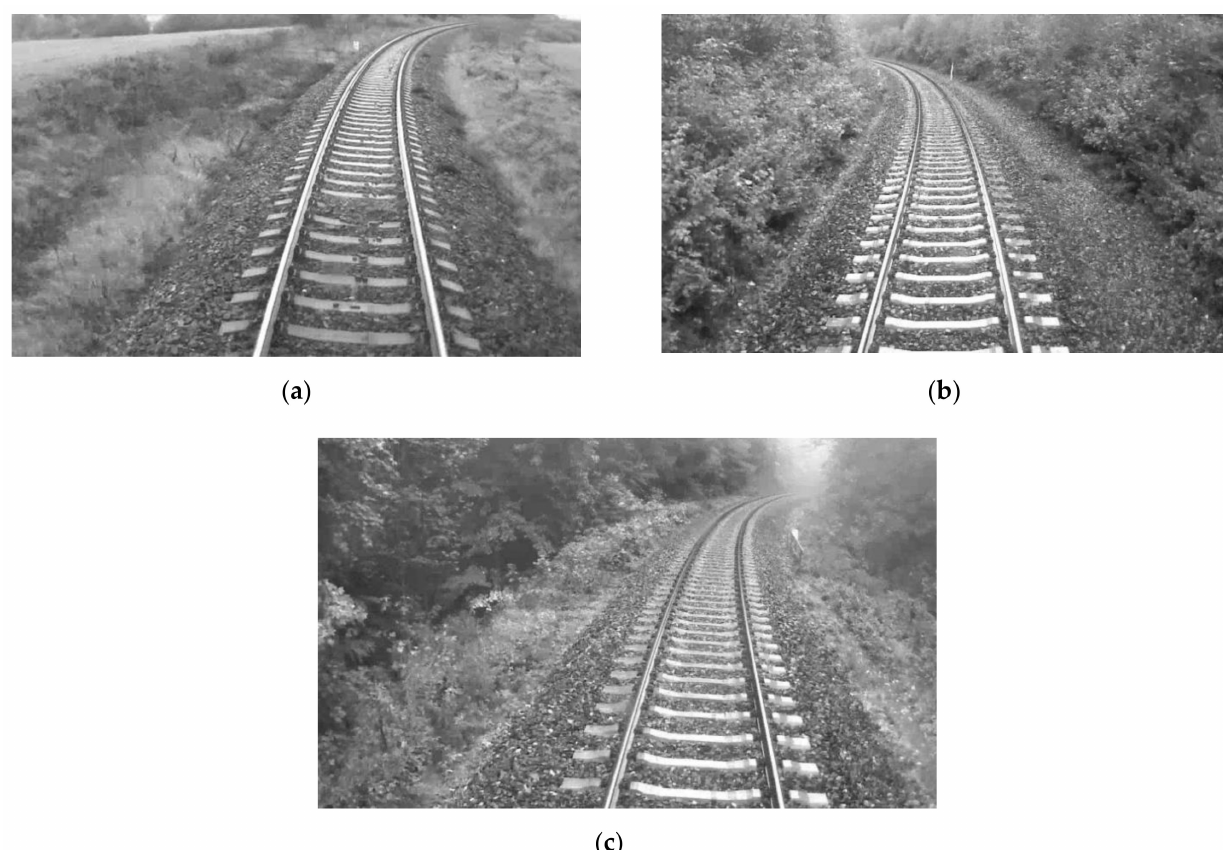
Figure 15. Examples of the railway with various levels of threat: ( a ) low level; ( b ) medium level and ( c ) high level